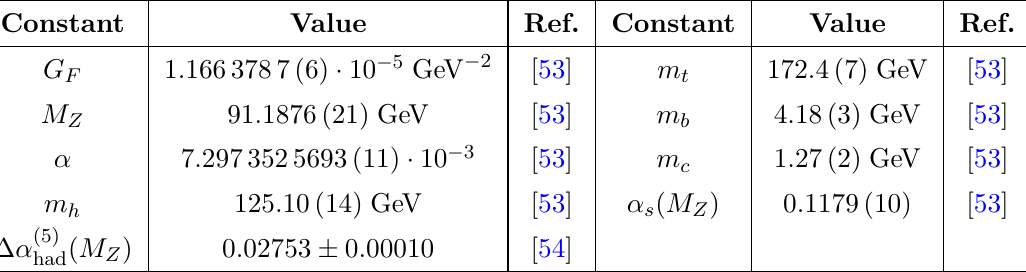
Table 1. Numerical values for the SM parameters used in the fits. m b and m c denote the bottom and charm running quark masses, in the MS scheme, at µ = 2 GeV , while m t is the value of the pole top mass extracted from cross-section